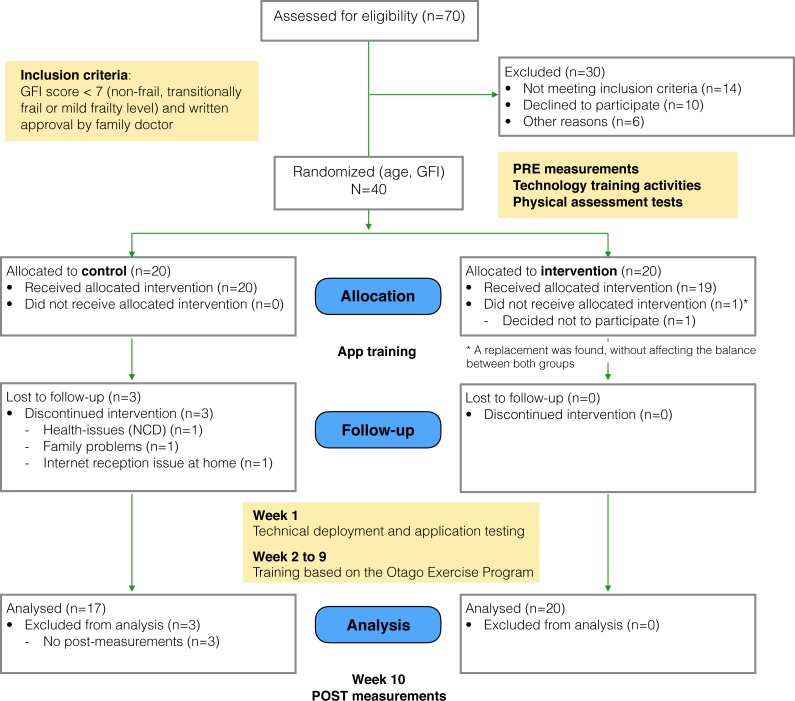
Study flow diagram.